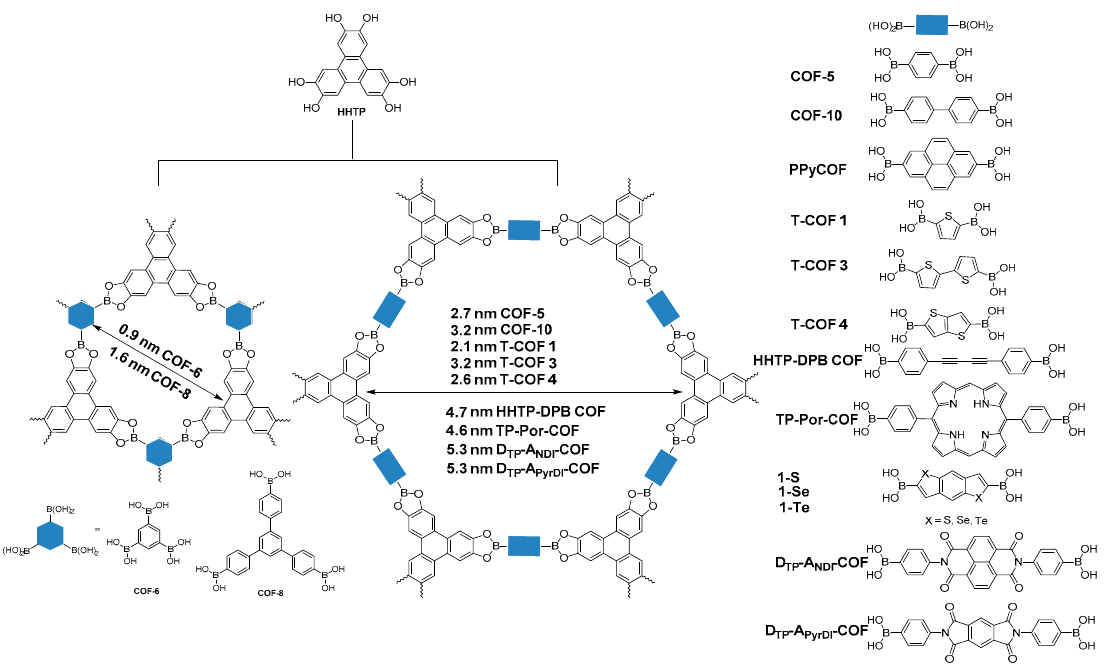
Figure 3. Construction of dioxaborole-linked COFs via the cross-condensation of triangular HHTP with ditopic or tritopic boronic acids to form 2D honeycomb layer structures.